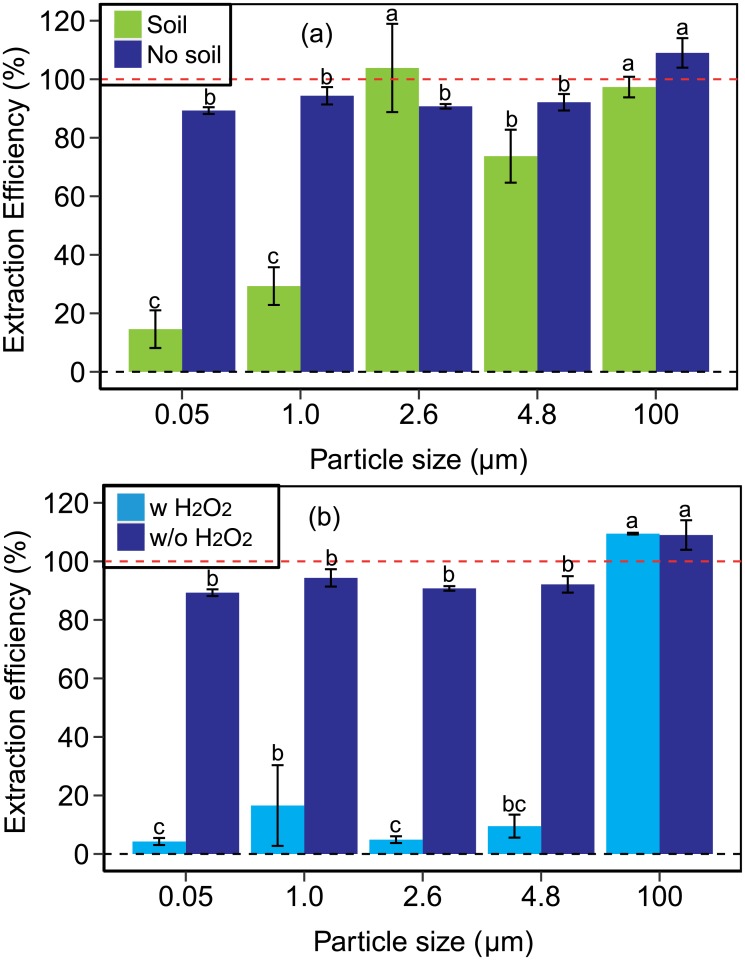
Extraction efficiency for different extraction procedures.Experimental extraction efficiencies of polystyrene beads for different extraction procedures. (a) No H2O2 digestion, beads were extracted from soil with H2O only (no biosolids could be extracted). Extraction efficiencies of control samples without beads were less than 0.5% (Table E in S1 Appendix). The no-soil treatment is extraction from beads in water only, without soil. (b) Beads extracted from water only with and without H2O2 digestion for 7 days. Note, the dark blue columns in (a) and (b) are the same data. Data represent mean and error bars are ± one standard deviation. Lowercase letters show the differences of extraction efficiencies among different size beads.